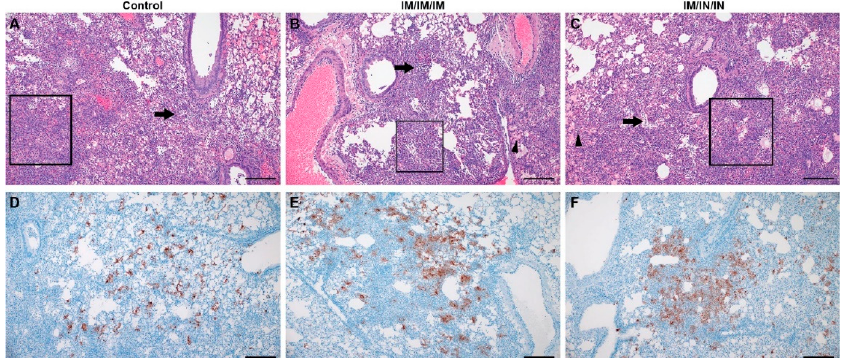
Figure 4. Histopathology and Immunohistochemistry of Control and Vaccinated Prime-Boost-Boost Hamster Lungs. Histopathology of control and vaccinated hamsters ( A – C ) are similar and characterized foci of moderate to severe interstitial pneumonia and disruption of loss of pulmonary architecture (boxes), regions of alveolar cellular exudate (arrows) and occasional foci of pulmonary edema (arrowhead; ( B , C )) are indicated. Immunohistochemistry of control and vaccinated hamsters is similar ( D – F ) with abundant SARS-CoV-2 immunoreactivity observed in type I and II pneumocytes and macrophages. Representative images for each group are shown. (Bar = 200 µm).